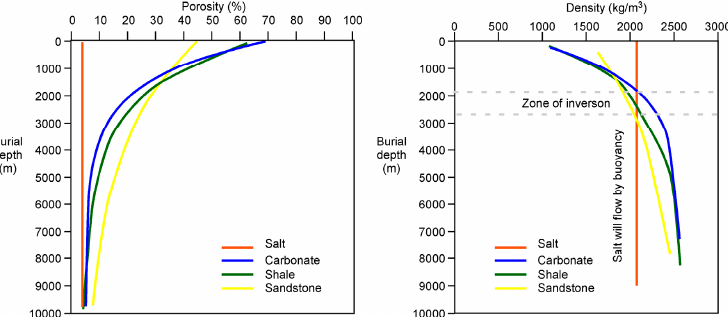
Figure 1. Salt has constant porosityand density, whereas sediments compact and lose porosity as they are buried. When the surrounding sediments have a higher density than salt, buoyancy will drive the upward movement of salt. The curves show the properties of sediments used in the modelling in this paper.